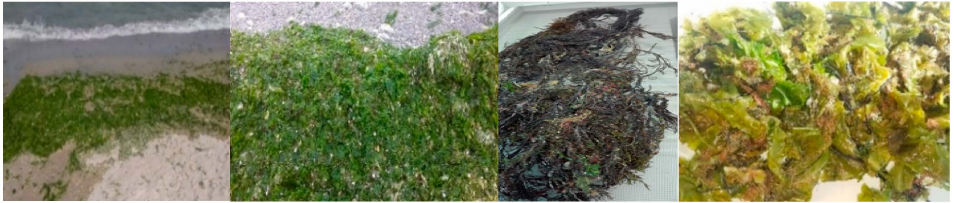
Figure 1. Green, brown, and red macroalgal biomass deposits along the Romanian Black Sea Coast ( Ulva , Cladophora , Cystoseira , and Ceramium species)